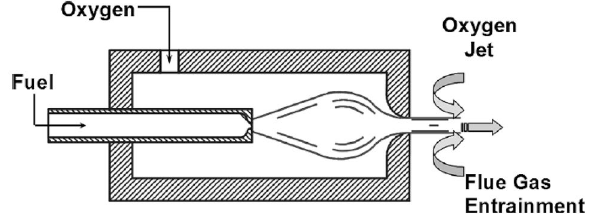
Fig. 13 Oxygen lancing principle [11]